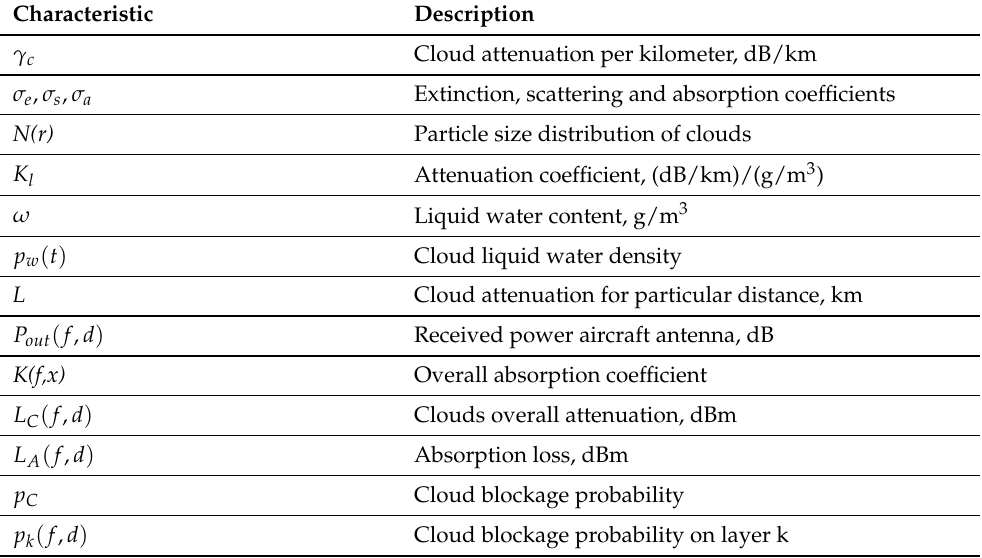
Table 1. The main notation utilized in this